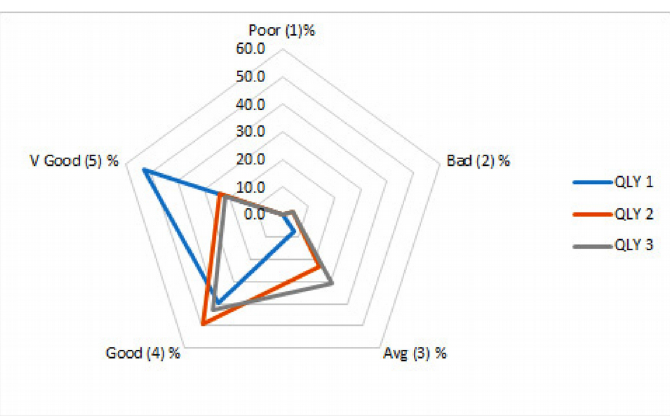
Figure 2. Radar diagram on quality